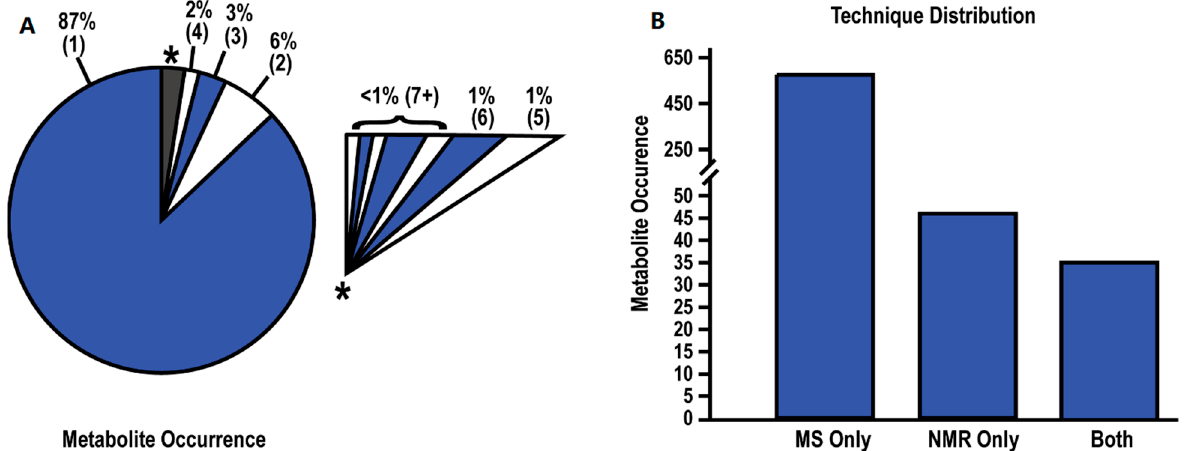
Figure 2. Summary of Metabolite Data. ( A ) Pie chart depicting the rate of metabolite occurrence across the 24 studies. Numbers within parentheses indicate the number of studies identifying the metabolites. An expanded view of the grey-starred slice of the pie chart is shown as an insert. ( B ) Bar chart depicting the number of metabolites identified by MS, NMR, or both techniques.